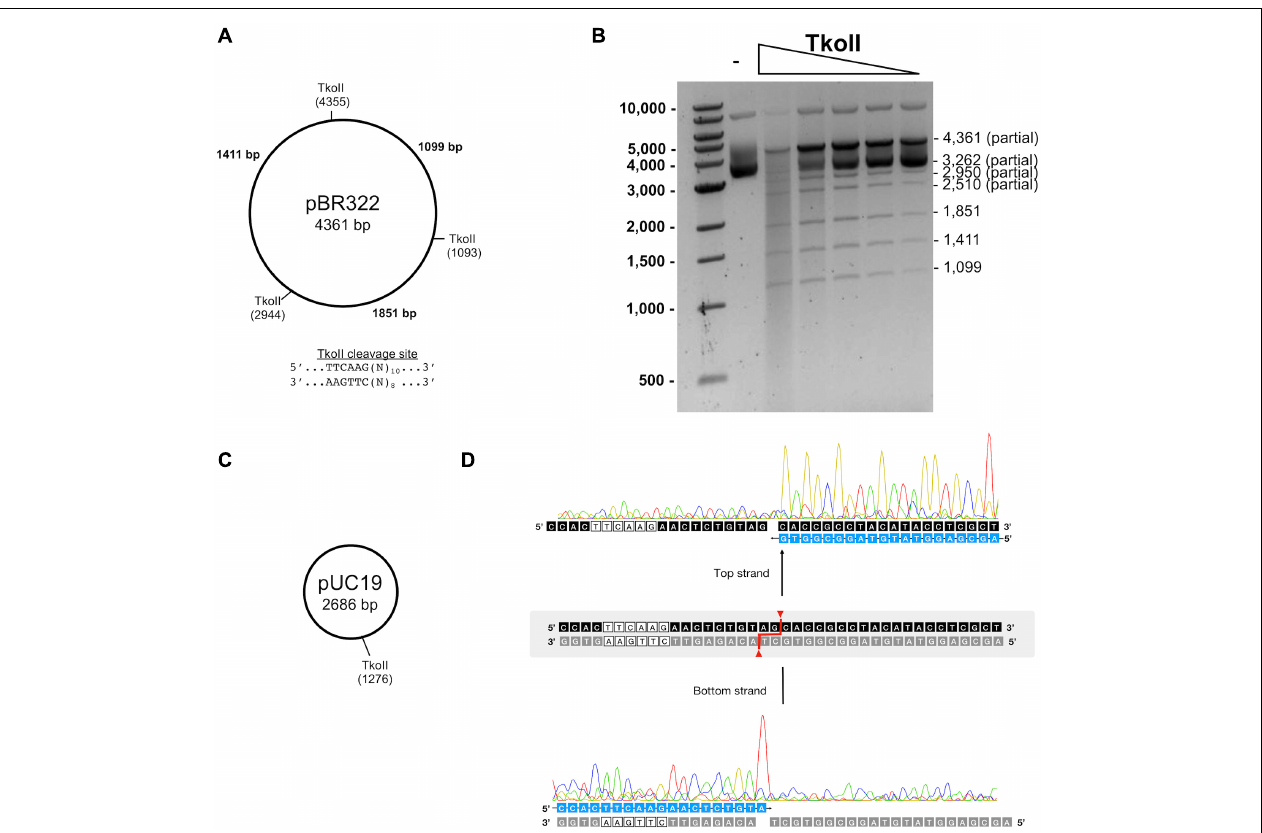
FIGURE 6 | Characterization of TkoII restriction endonuclease activities. (A) Predicted TkoII recognition sites in plasmid pBR322 are at positions 1093, 2944 and 4355. (B) TkoII was incubated with pBR322 in 1X NEBuffer 1 supplemented with SAM and 90mer trans-DNA for 30 min at 65 ◦ C. Reactions were halted with Proteinase K and loading dye and separated on a 1% agarose gel. Lane 1 is a 1 kb DNA ladder. Lane 2 is pBR322 alone and lanes 3–7 are decreasing amounts of TkoII (10–0.62 nM). (C) TkoII cleaves pUC19 at a single site. (D) pUC19/TkoII cut fragments were analyzed by run off sequencing to determine TkoII cut sites on the top and bottom strands: TTCAAG(N) 10 /(N) 8